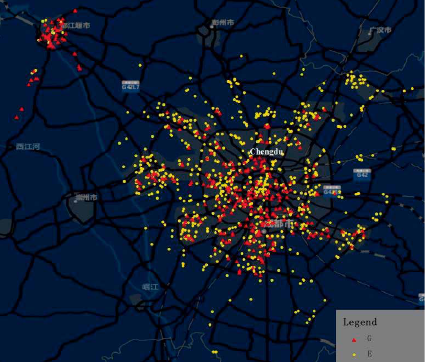
Figure 5: Car sharing station distribution for 𝐺 & 𝐸 . Figure 6: Hourly demand for 𝐸 .